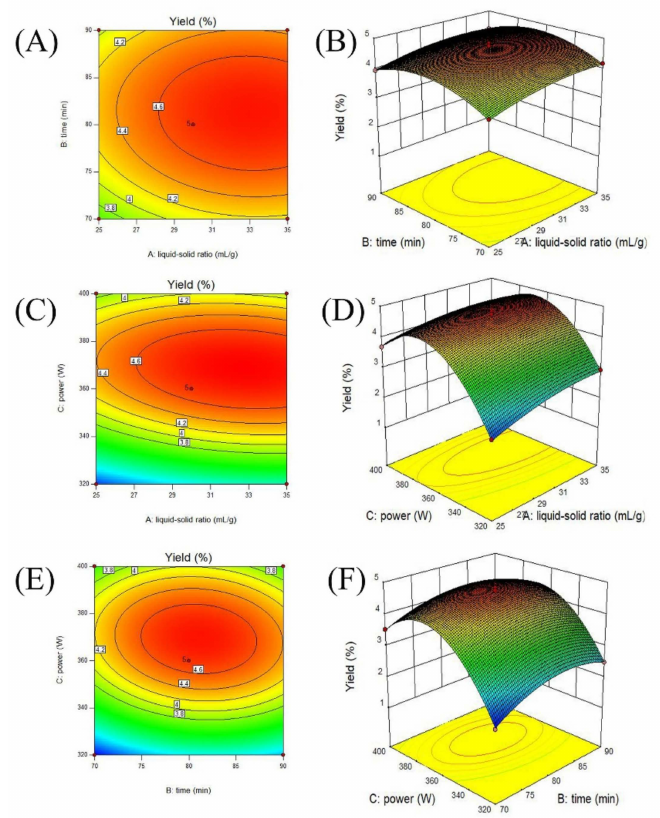
Figure 2. Contour plots ( A , C , E ) and response surface ( B , D , F ) of the polysaccharide production with various variables, including liquid-to-material ratio, ultrasonic time, and ultrasonic